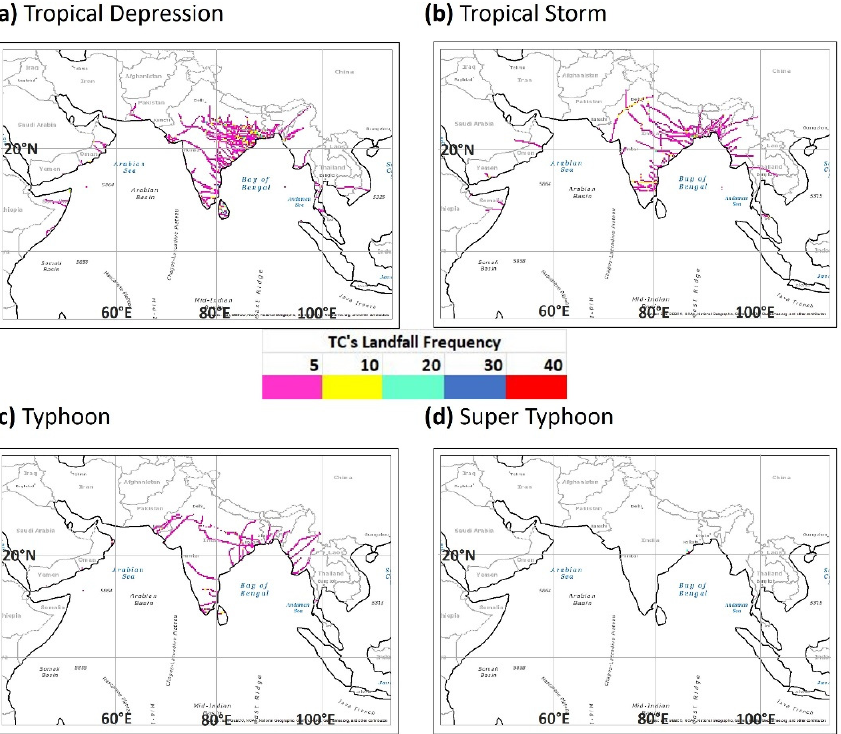
Figure 9. TC landfall frequency separated into intensity categories using the combined wind dataset: ( a ) tropical depression; ( b ) tropical storm; ( c ) typhoon; and ( d ) supertyphoon.